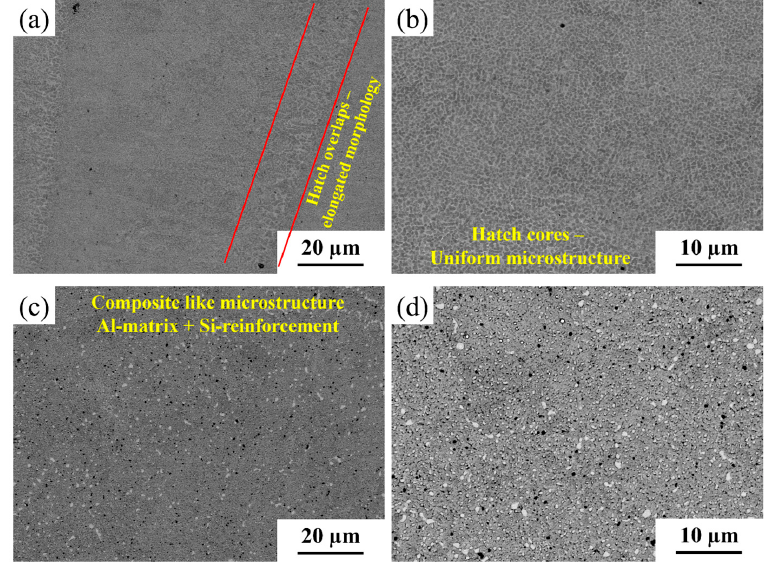
Figure 2. Back-scattered scanning electron microscopy images of SLM-fabricated Al-12Si samples along the cross section ( X – Y plane): ( a , b ) as-prepared; ( c , d ) annealed at 573 K.